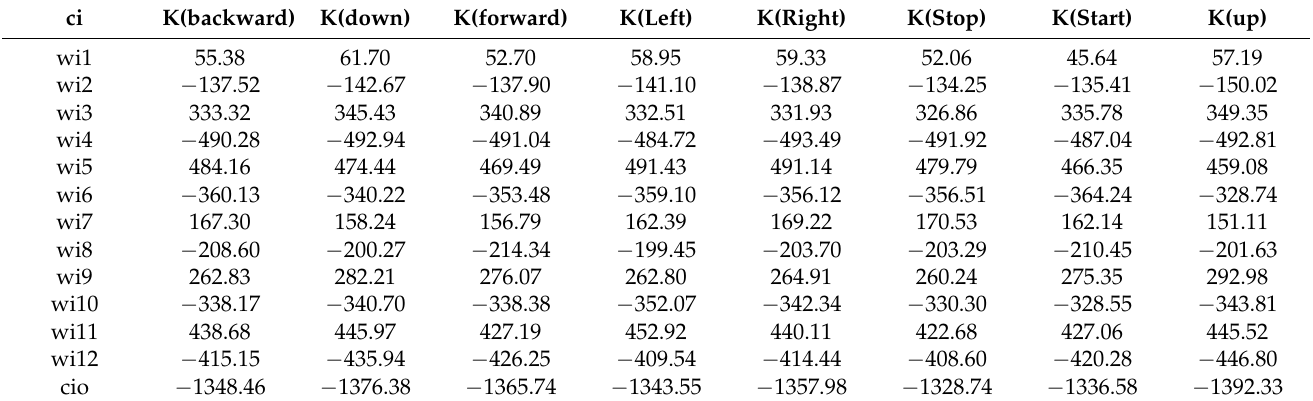
Table 3. The coefficients of classification functions.